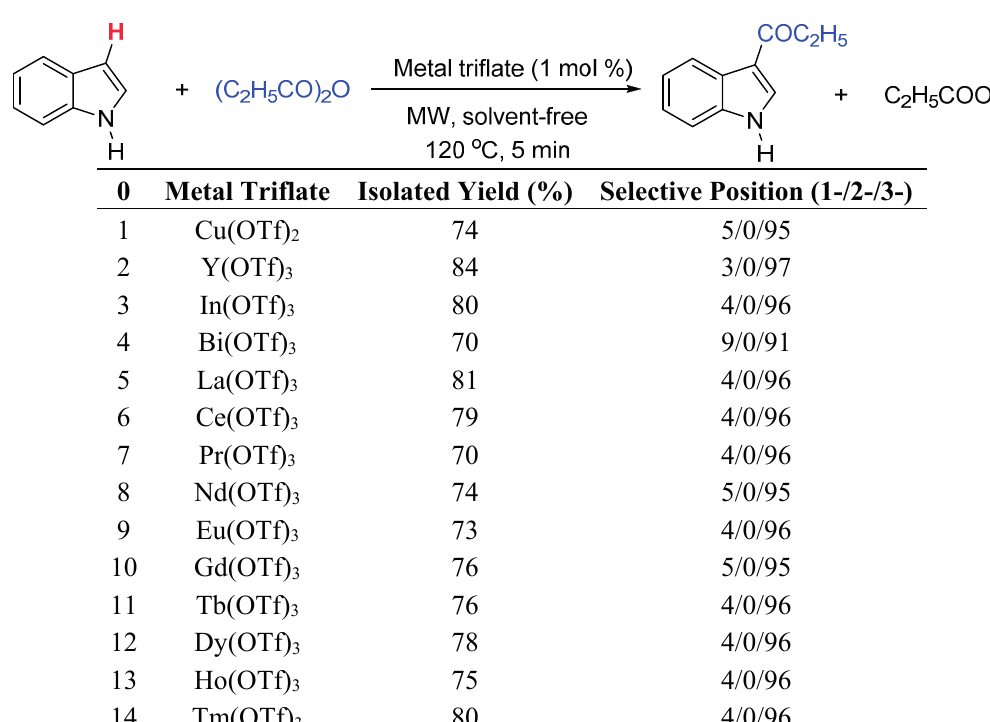
Table 1. Effect of metal triflates on Friedel-Crafts propionylation of indoles under microwave